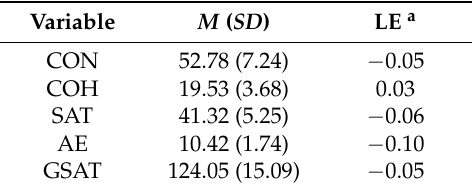
Table 3. Correlation coefficients for the relationship of overall satisfaction with the relationship and its components to life events.